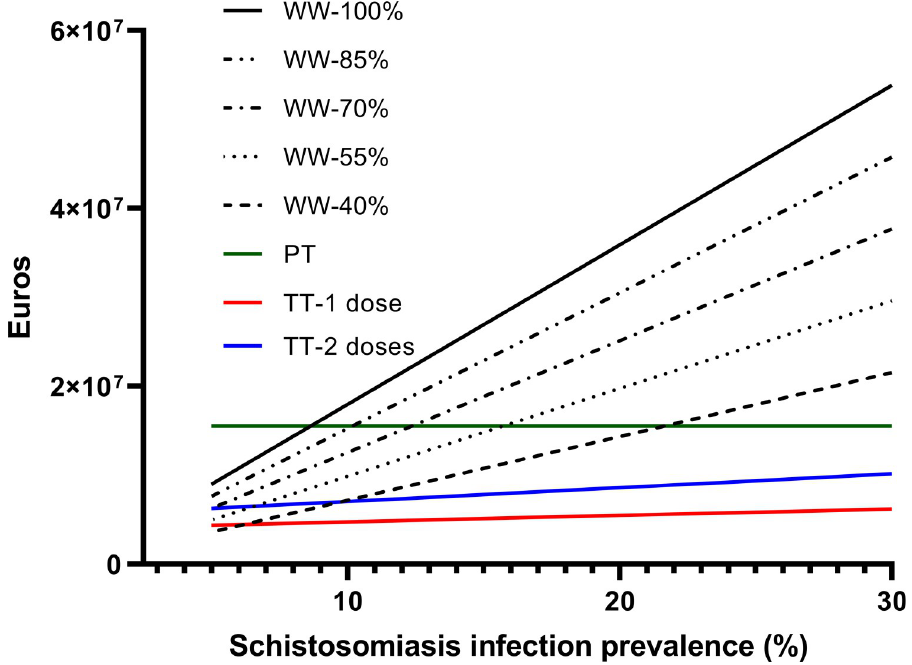
Fig 1. Total projected cost for each strategy at different prevalence rates and for the WW strategy, at five percentages of the maximum cost of treatment of associated morbidities * . * WW: Watchful and waiting strategy; PT: Presumptive treatment; TT: Test and treat